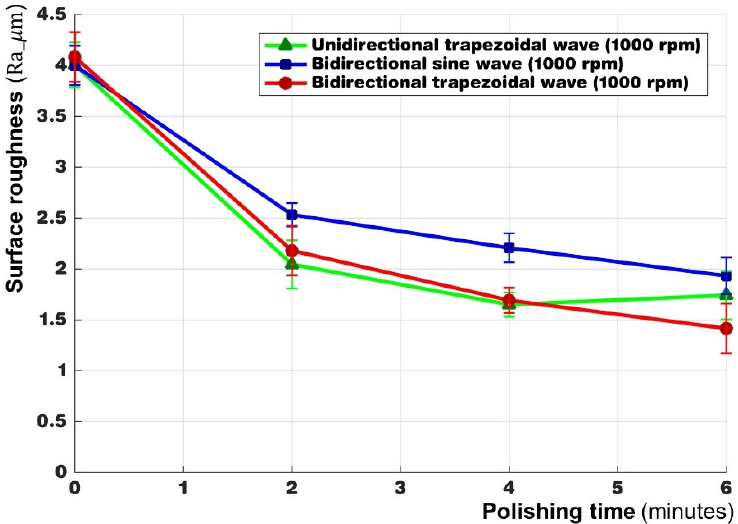
Figure 5. Comparison chart of average surface roughness and polishing time of three motor operating modes.